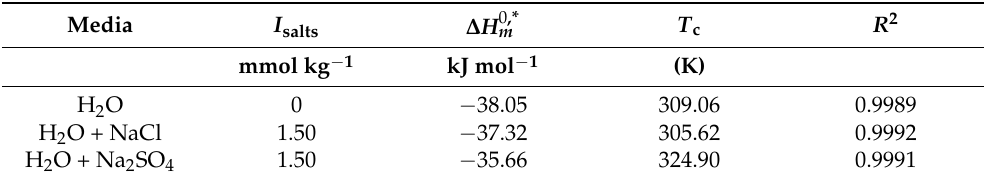
Table 6. Enthalpy–entropy compensation parameters for CPC + 0.1% ( w / v ) PVP systems in H 2 O and aq. salts